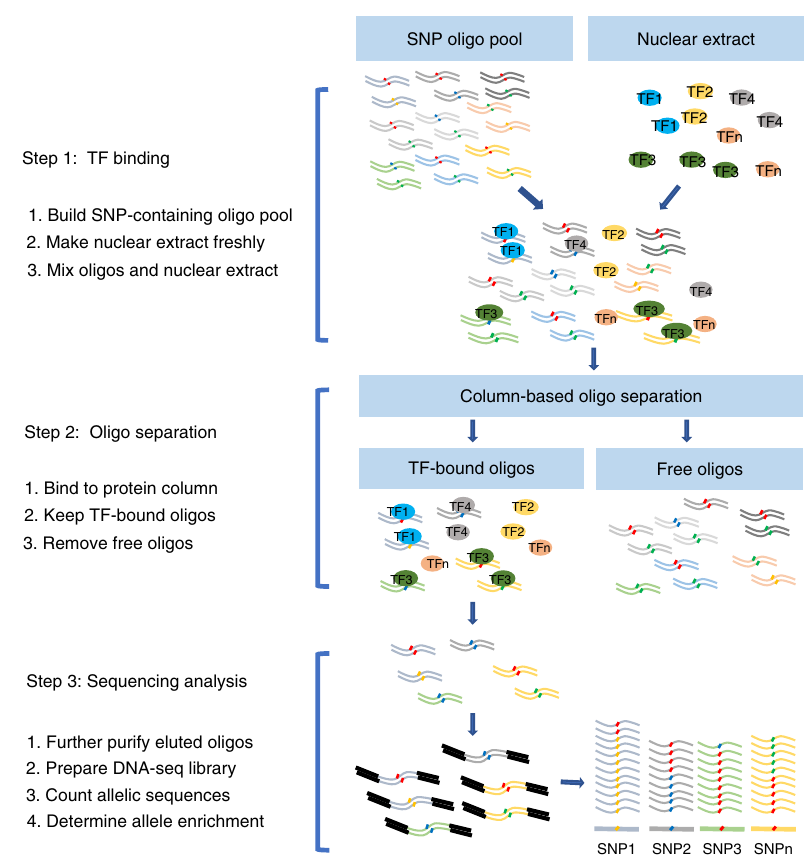
Fig. 1 Work fl ow of SNPs-seq. The SNPs-seq includes three key steps: binding of SNP-containing oligos to nuclear protein, separation of protein-bound oligos from protein-free oligos, and sequencing library preparation and